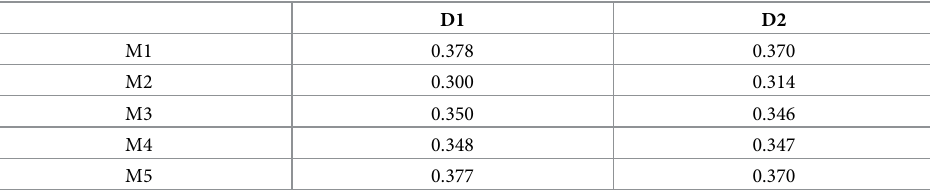
Table 4. Pearson correlation between true and estimated breeding values under different models 1 and datasets 2 .